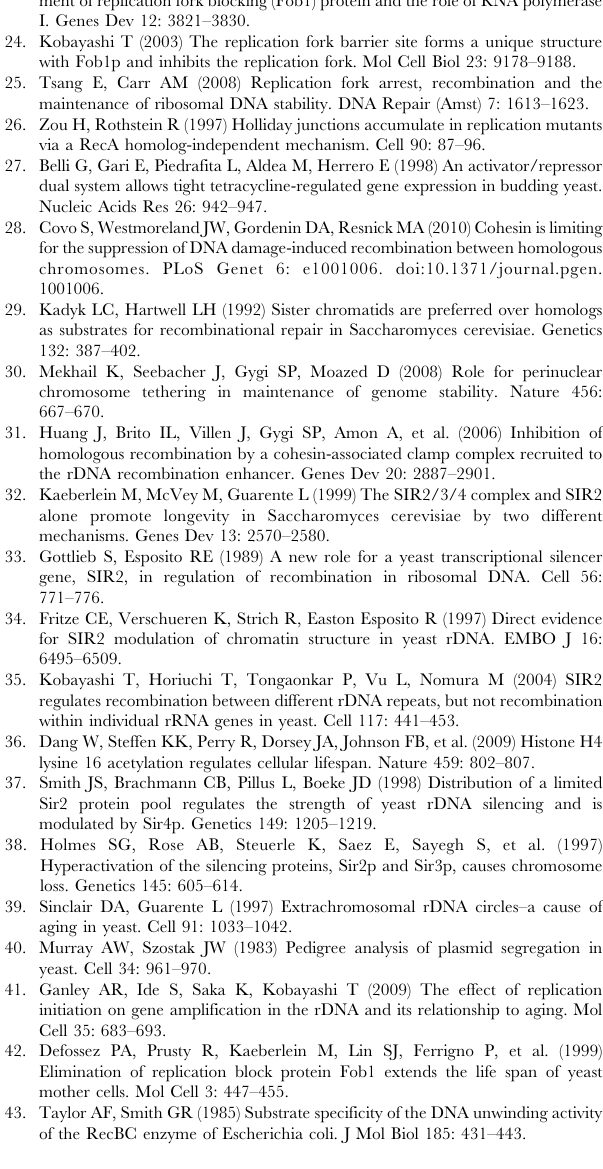
Figure S2 Preparation and normalization of ERC southern blotting. ERC Southern blot of total genomic DNA isolated from wild type cells and digested with BamHI and with or without RecBCD. Arrow indicates the linear rDNA array. Table S1 Yeast strains used in this study.